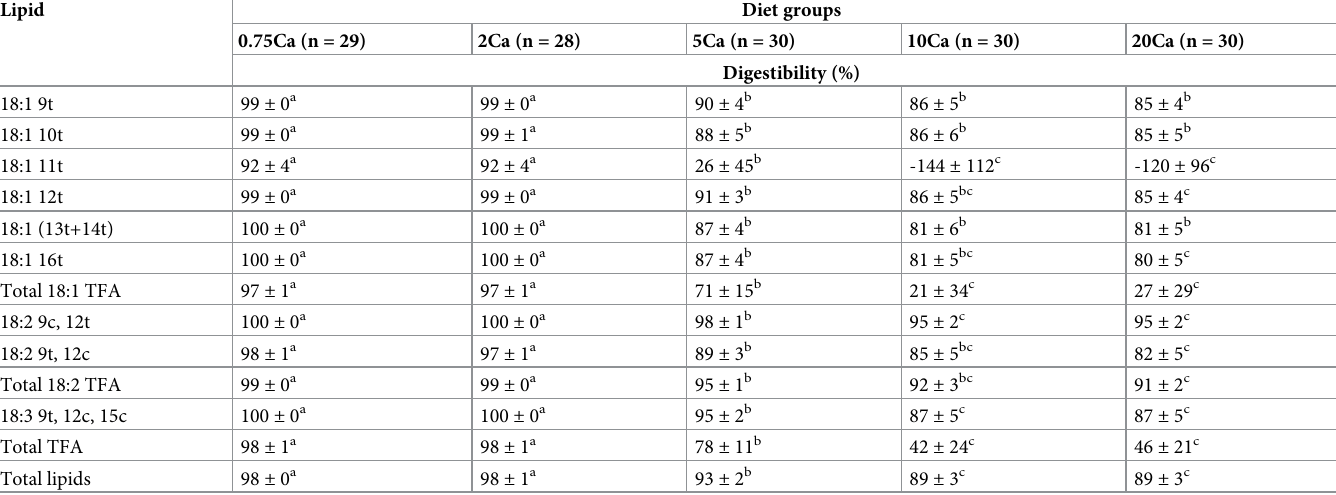
Values are means ± SD. Values in a row without a common superscript letter differ, p < 0.05. CLA: conjugated linoleic acid; MUFA: monounsaturated fatty acids;